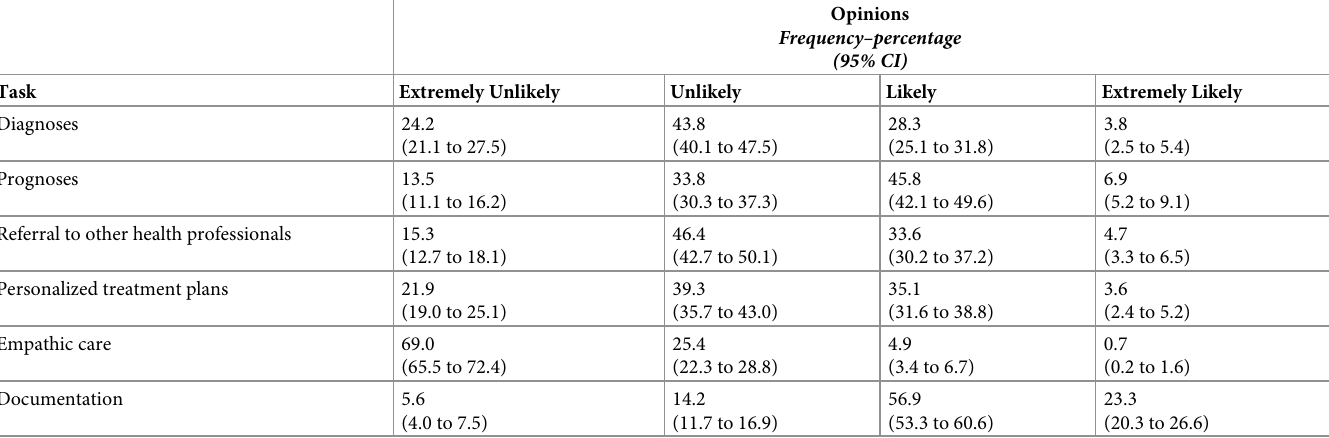
Table 2. Opinions about the likelihood of future technology replacing GP tasks � .